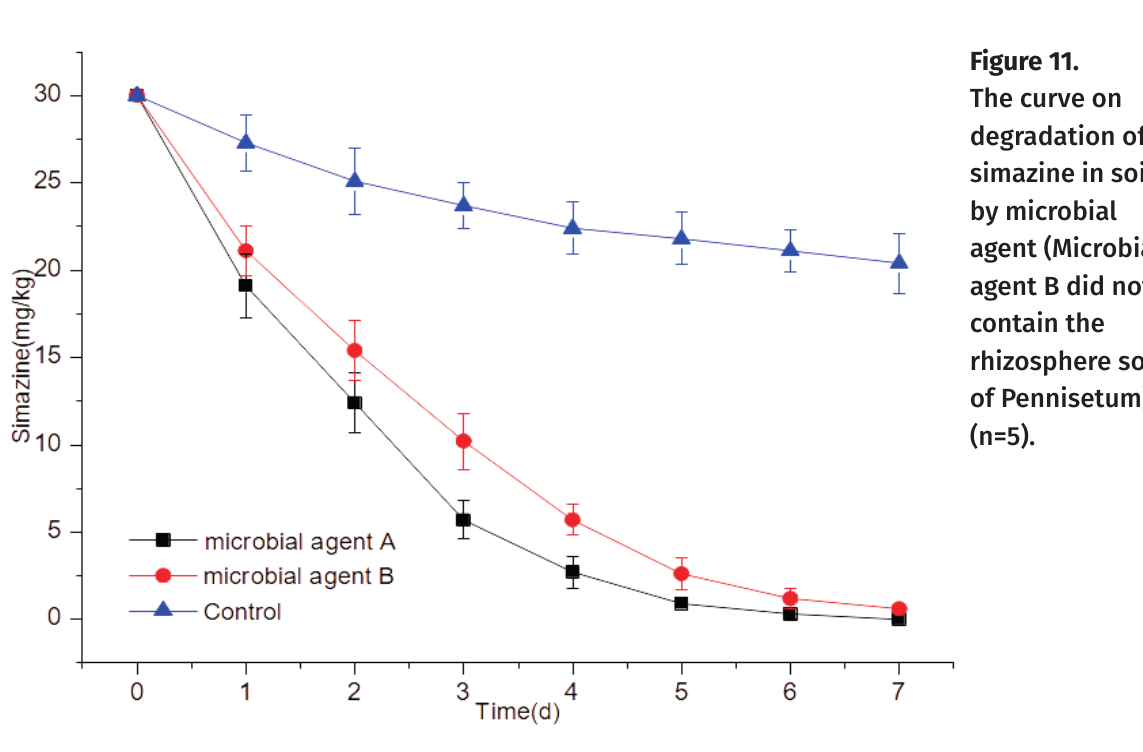
Figure 11. The curve on degradation of simazine in soil by microbial agent (Microbial agent B did not contain the rhizosphere soil of